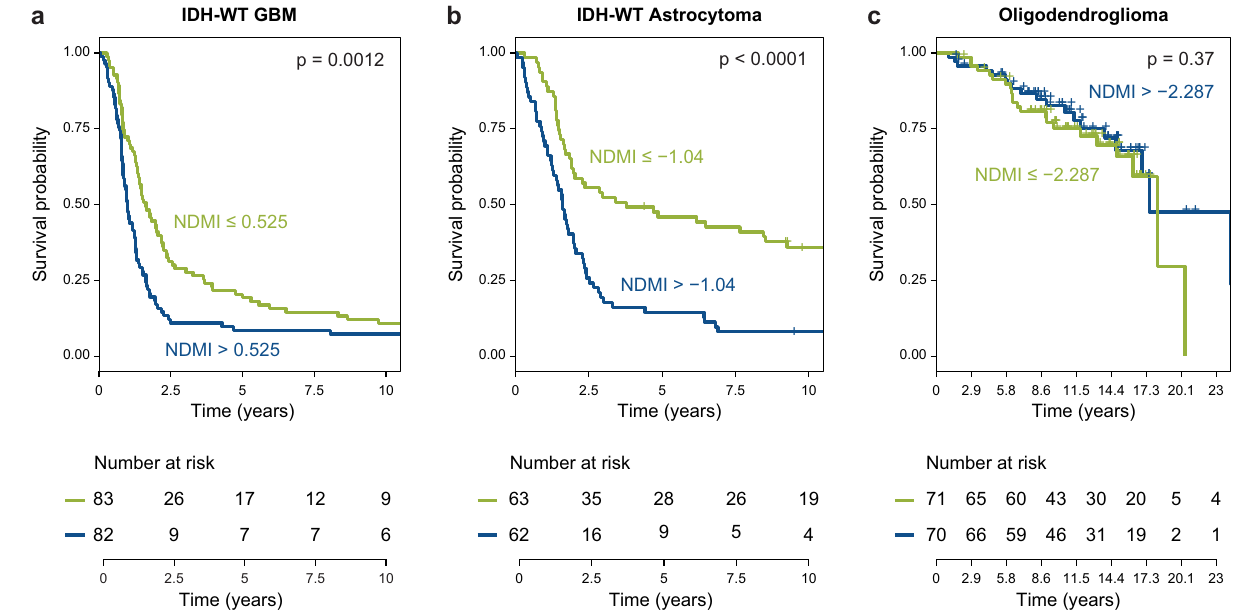
Fig. 7 | Association of NDMI scores and glioma survival. a The fi gure shows the Kaplan – Meier survival curves for NDMI score split at the median in the test set ’ s IDH -wildtype GBM patients. b The fi gure shows the Kaplan – Meier survival curves